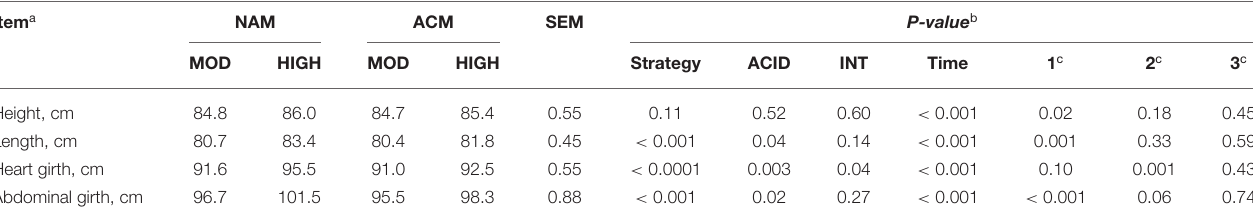
TABLE 4 | Least square means for effect of milk feeding strategy and milk acidification on body structural measurements for calves fed 6 (MOD) or 12L (HIGH) of milk with (ACM) or without (NAM)